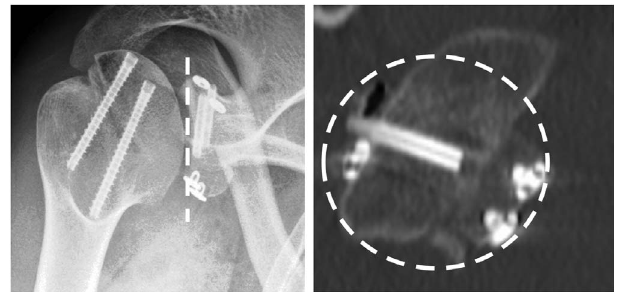
Figure 3. Revision